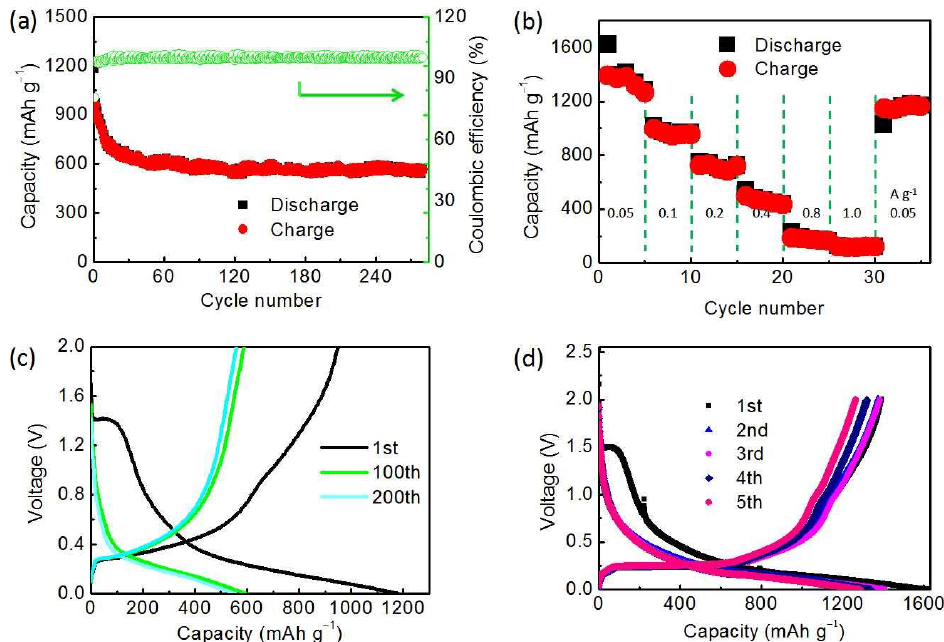
Figure 10. ( a ) Cycle performance of the Ge composite film. ( b ) Rate capability of the Ge composite film. The discharge—charge curves of the germanium composite film ( c ) at a current density of 0.2 A g −1 and ( d ) at a current density of 0.05 A g −1 .